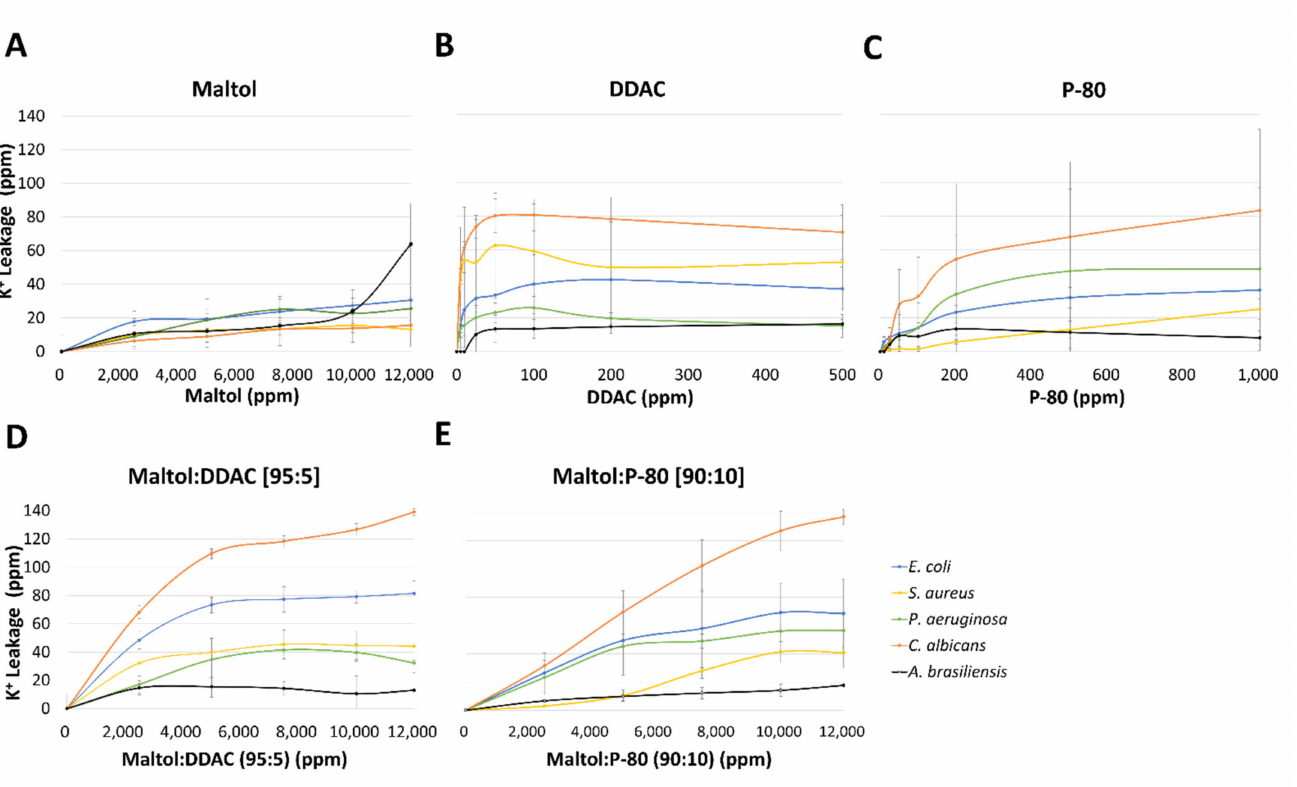
Figure 4. Potassium leakage from the five pharmacopeia microorganisms, E. coli , S. aureus , P. aeruginosa , C. albicans, and A. brasiliensis , in response to increasing concentrations of the tested compounds; ( A ) maltol, ( B ) DDAC, ( C ) P-80, ( D ) maltol and DDAC (95:5), and ( E ) maltol and P-80 (90:10). Results are presented as ppm of potassium (K + ) cations measured using emission flame photometry. Data are based on three independent experiments and represented as the average potassium leakage (ppm) ±